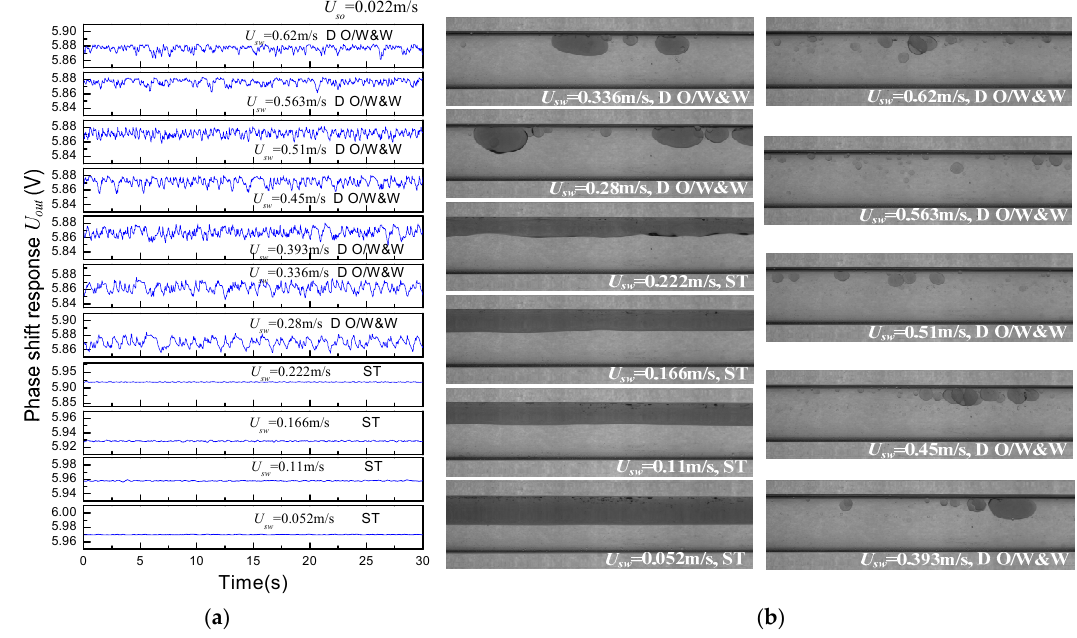
Figure 13. Phase shift response of ( a ) the CCS and ( b ) oil–water images ( U so = 0.022 m/s).